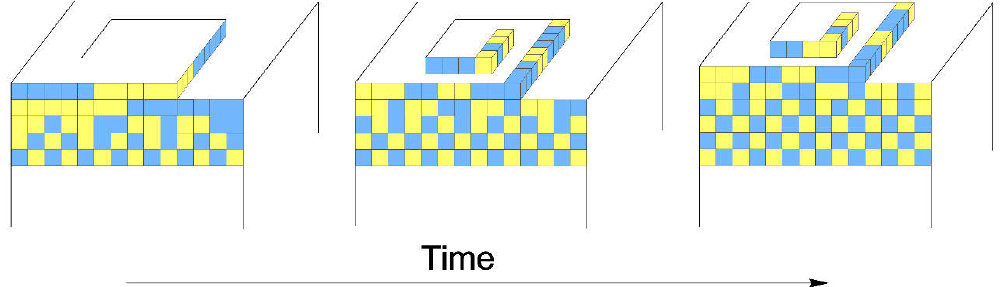
Figure 4. A simplified sketch showing the growth mechanism we proposed in the paper for dolomite. From left to right, the advancement by means of the spiral growth mechanism of the (10.4) face of dolomite is represented. The two disordered layers (i.e., the layers forming in contact with the mother solution) are schematized by a random distribution of CaCO 3 (blue) and MgCO 3 (yellow) growth units (cubes). The third layer, the layer underlying the two disordered ones and suffering a partial ordering by means of intra‐crystalline diffusion, is schematized by a less random distribution of blue and yellow cubes. Instead, the ordered layers, the layers below the partially ordered one, are schematized by a perfect alternation of blue and yellow cubes in each layer.